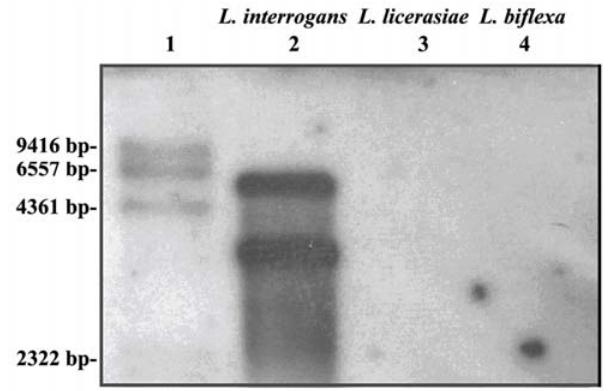
Figure 3. Southern blot to determine the presence of LigA in ‘‘L. licerasiae’’ serovar Varillal. Lane 1, DIG-labeled marker; lane 2, L. interrogans serovar Icterohaemorrhagiae strain HAI188 (positive con- trol); lane 3, ‘‘L. licerasiae’’ serovar Varillal; lane 4, L. biflexa serovar Patoc I T .